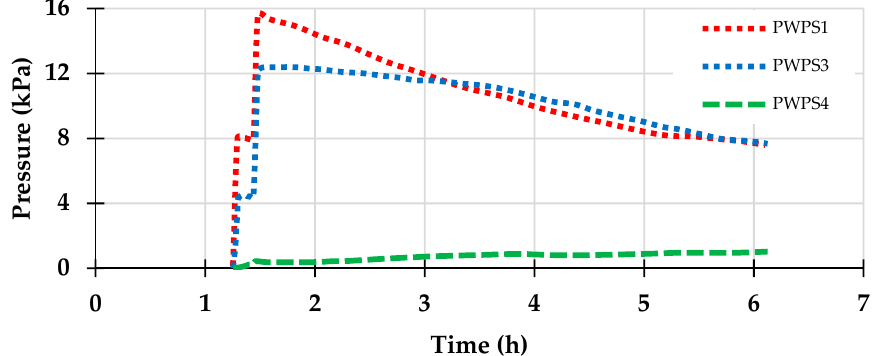
Figure 13. The pore water pressure at the base of stope (PWPS1), at 20 cm above the stope (PWPS3), and under the barricade (PWPS4).